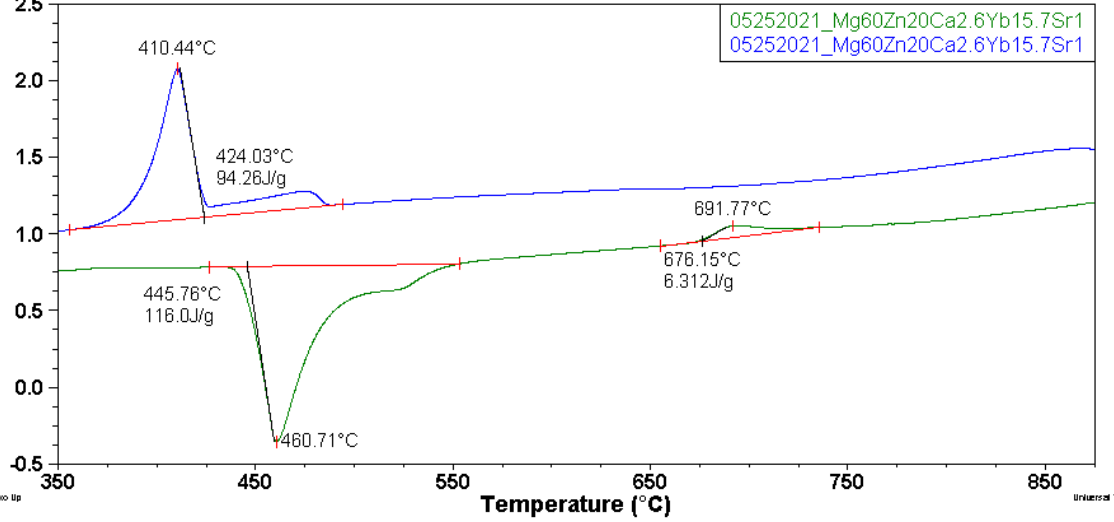
Figure 3 . DSC heating and cooling curves of Mg 60 Zn 20 Ca 2.6 Yb 15.7 Sr 1.7 alloy in a form of pla t e, 20°/min.